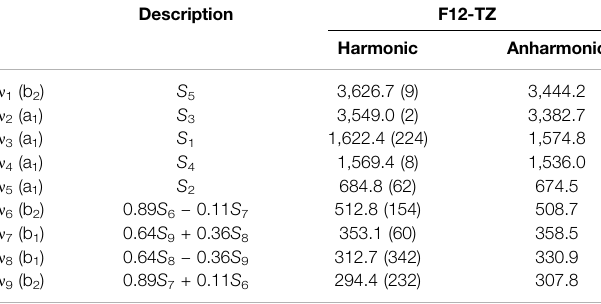
TABLE 8 | Vibrational Frequencies (in cm − 1 ) of HMgNH 2 with MP2/aug-cc-pVTZ intensities in parentheses (in